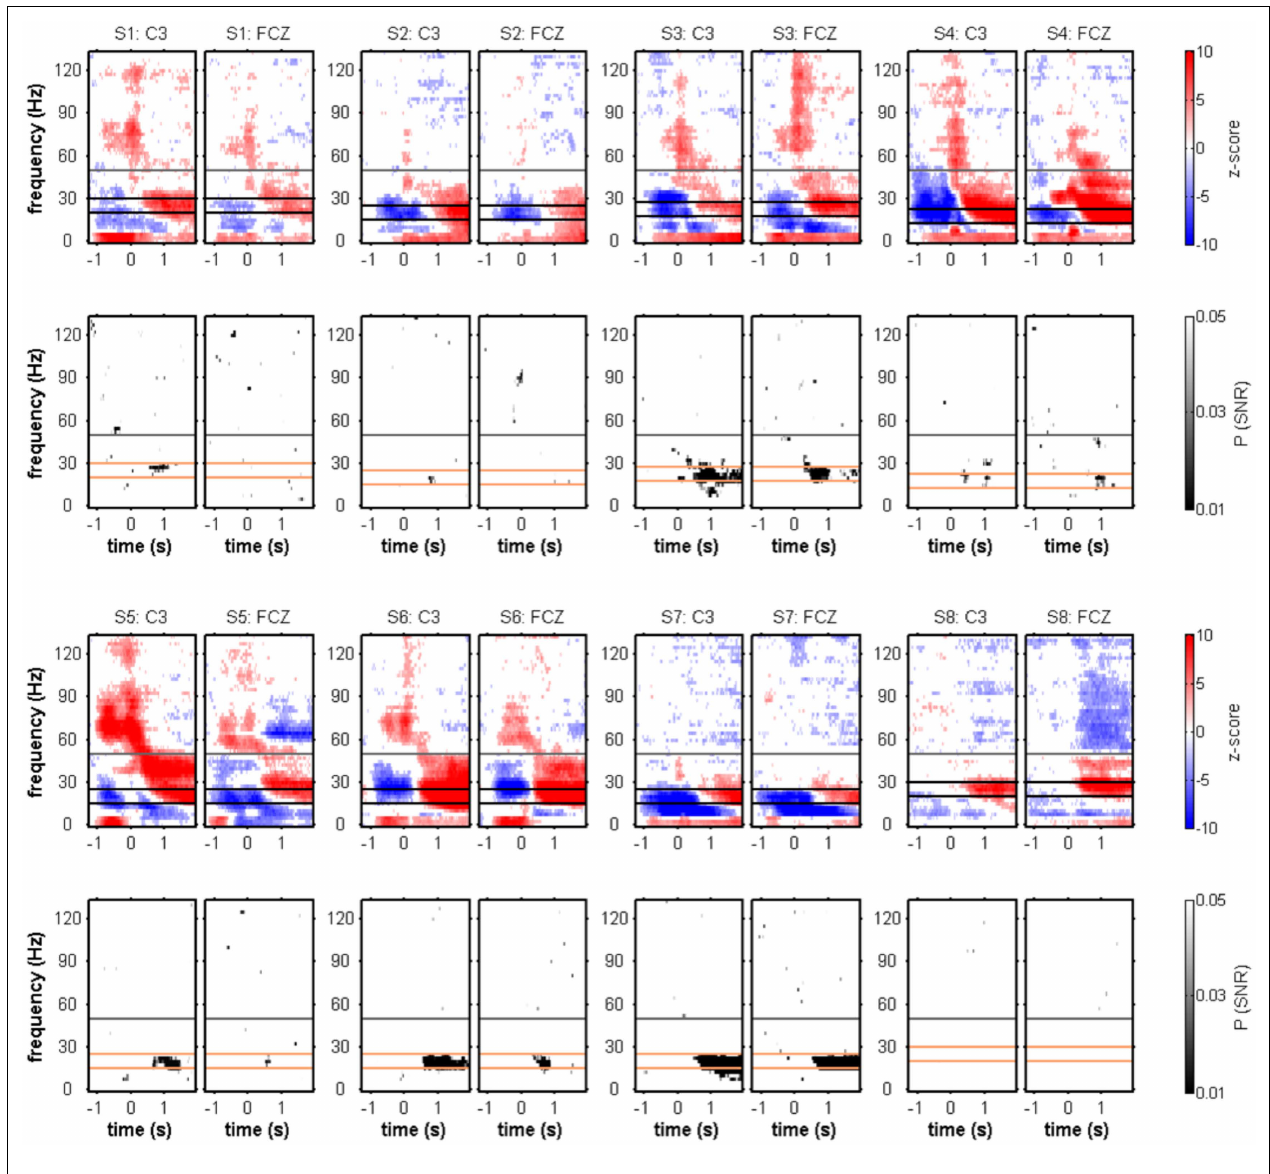
FIGURE 5 | Movement end-aligned individual spectral power changes and SNR of movement class tuning. Conventions as in Figure 3 . MER1 and MER2 (see Figure 2 ) were evident in the individual subjects. Four subjects (S3–6) showed a continuous transition from MER1 to MER2 at either electrode position C3 or FCZ, or both. A (see Table 2